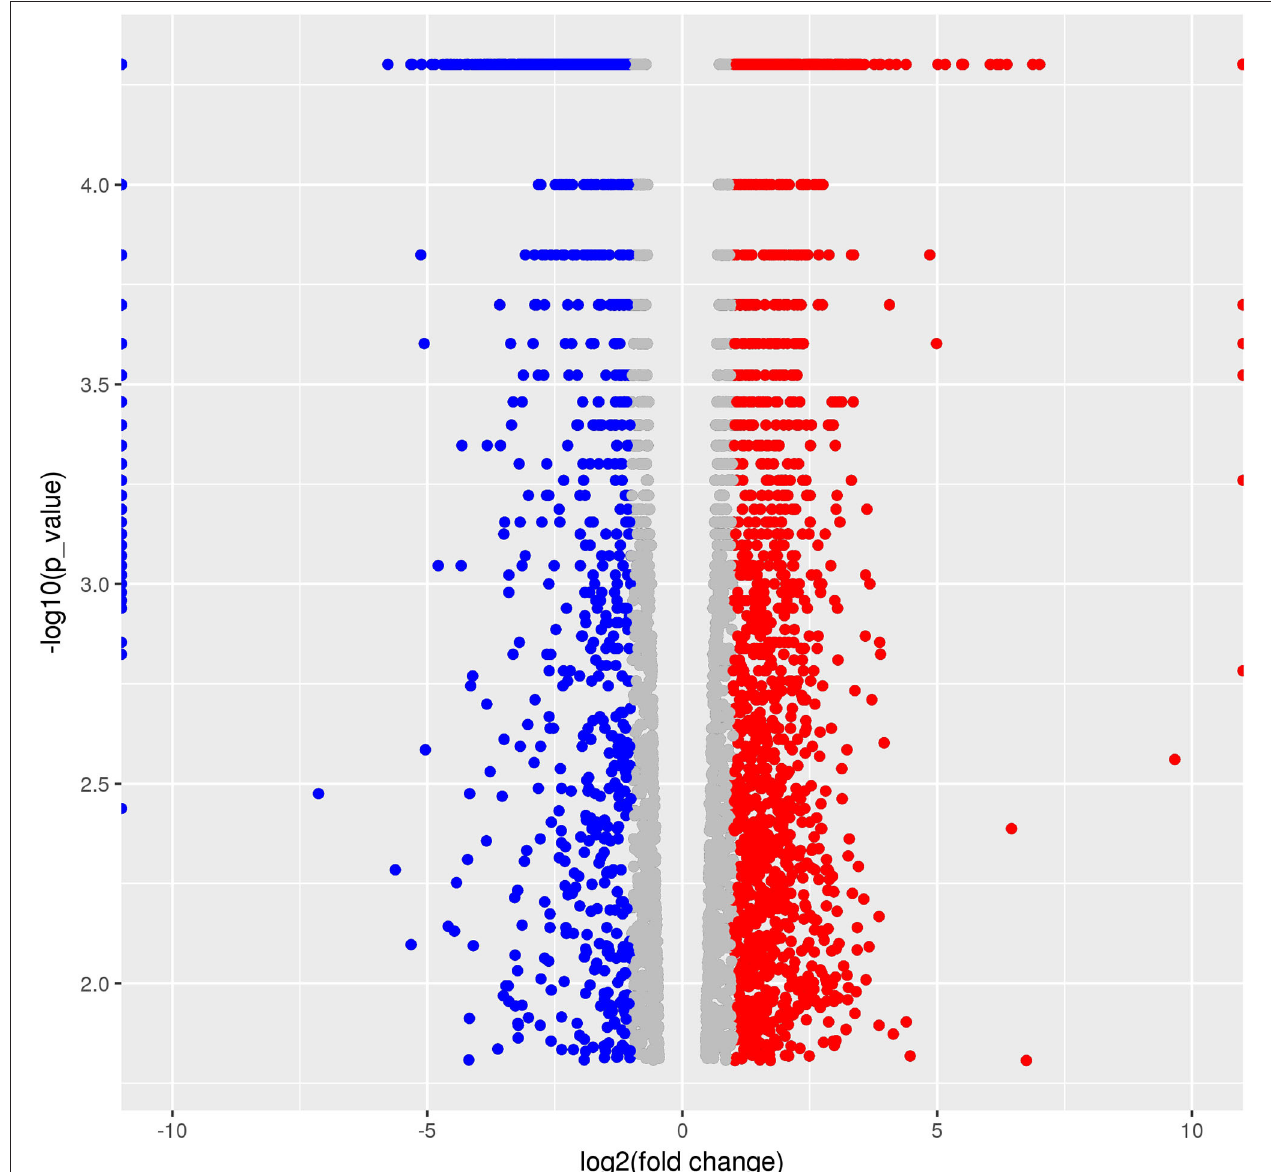
FIGURE 2 | Volcano Graphic. In the figure each dot demonstrated a gene expression in two populations. The horizontal ordinate is the log2 value of folder change between populations (NX/JX). The y-coordinate is the –log10 of the p -value. Dots in red indicated the up-regulated, in blue were down-regulated, and in gray were those with no significant